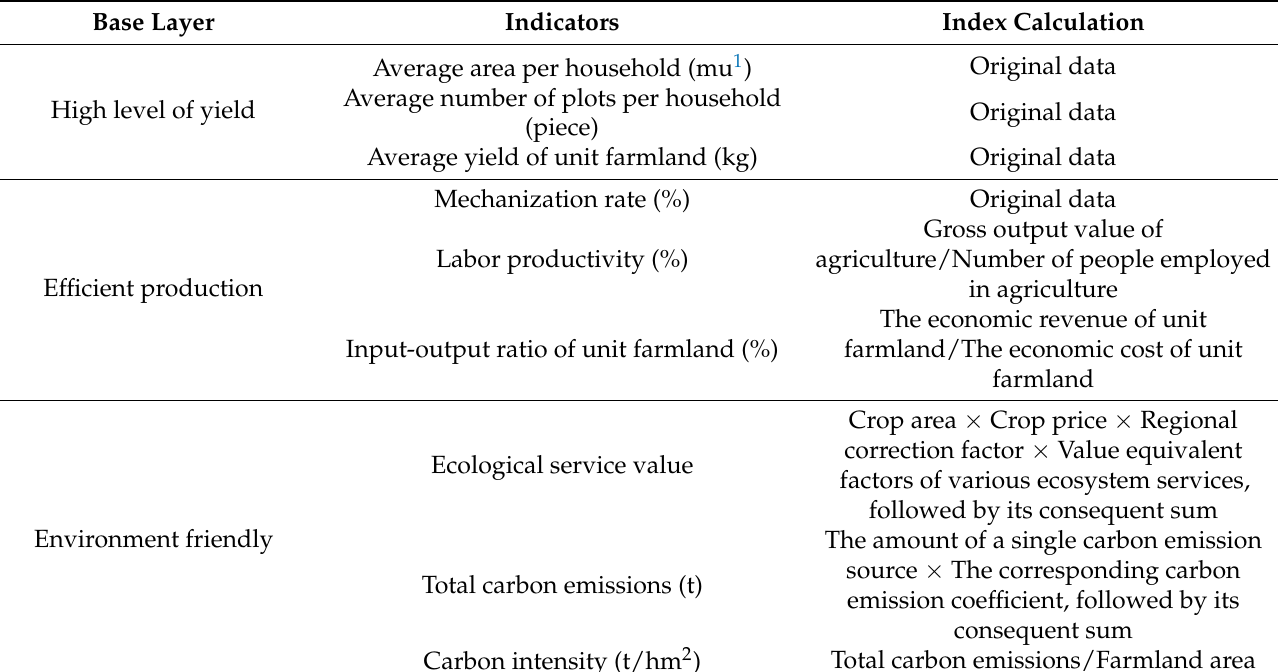
Table 1. Indicator system for evaluating impacts of the reform on agricultural